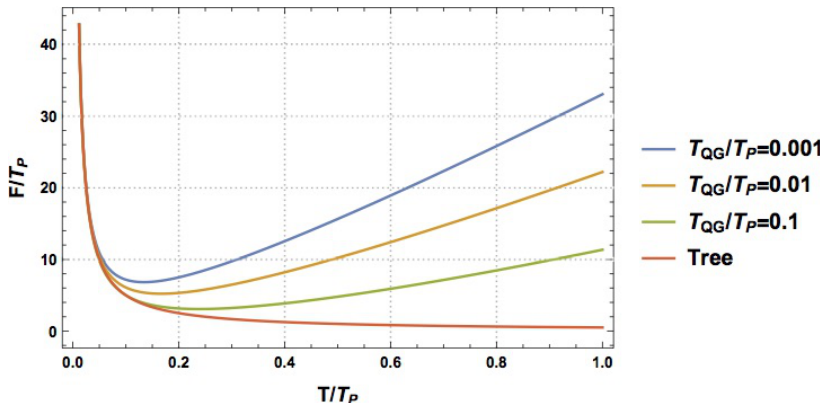
Figure 3 . The free energy as a function of the temperature of Schwarzschild black hole at tree level and including the one-loop contribution. Without loss of generality, only the contribution of the graviton to (cid:4) is